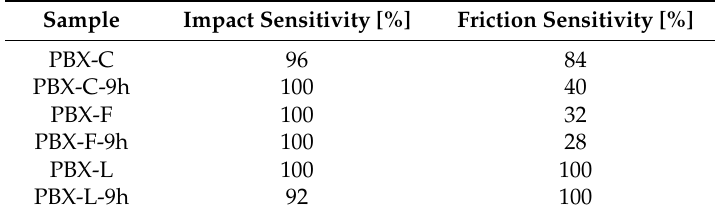
Table 1. Impact and friction sensitivities for conventional HMX/fluoropolymer (PBX-C), PDA modified conventional HMX/fluoropolymer with in situ polymerization of dopamine for 9h (PBX-C-9h), fine and high quality HMX/fluoropolymer (PBX-F) and its coating system (PBX-F-9h), large and high